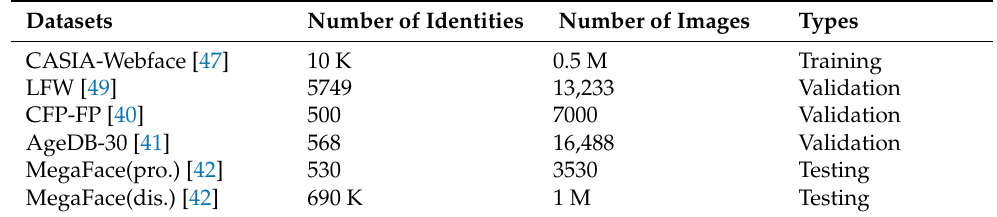
Table 1. Datasets for Training and Testing.